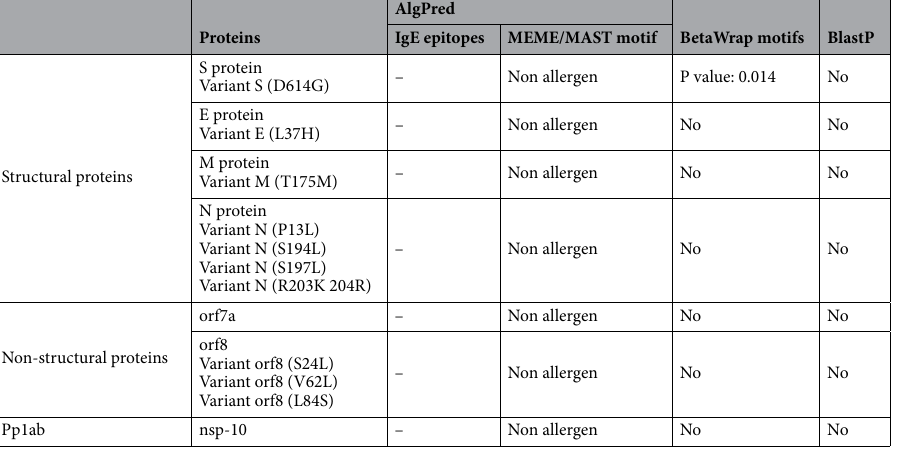
Table 5. Allergenicity, BetaWrap motifs and host proteome similarity results predicted by AlgPred, BetaWrap and BlastP, respectively.